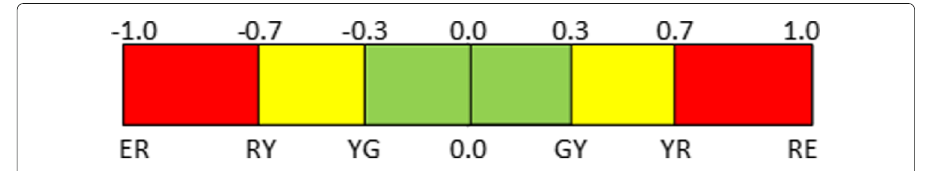
Fig. 2 Traffic light model on top of